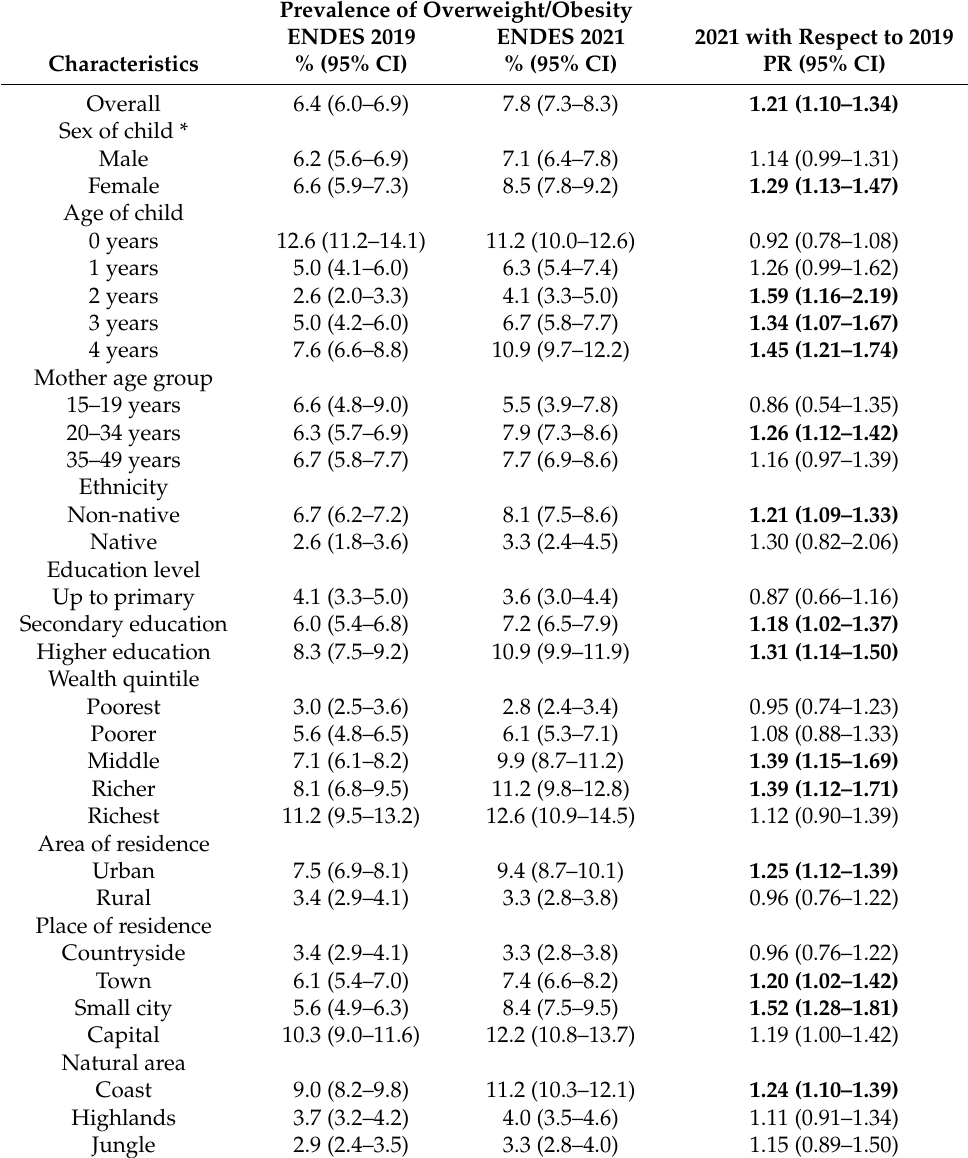
Table 2. Summary statistics of children under 5 years of age and their mothers included in the